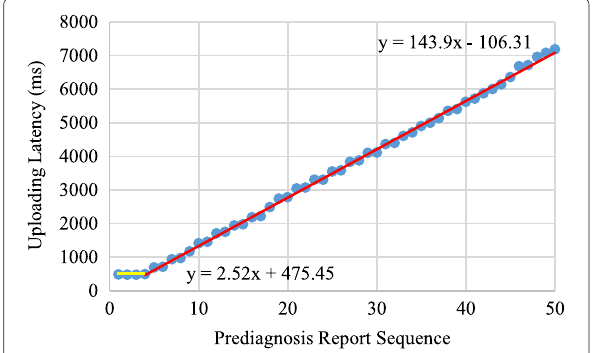
two-part linear regression